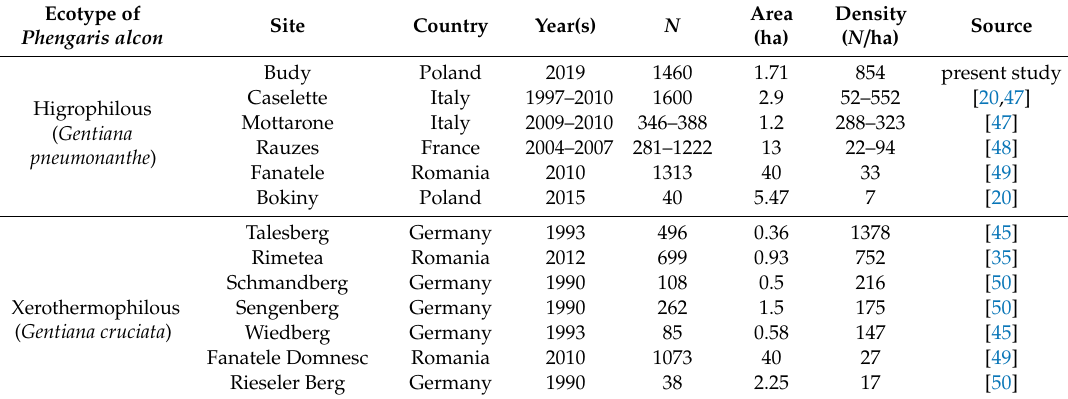
Table 1. Estimated adult population sizes ( N ) and densities derived from MRR studies of Phengaris alcon across